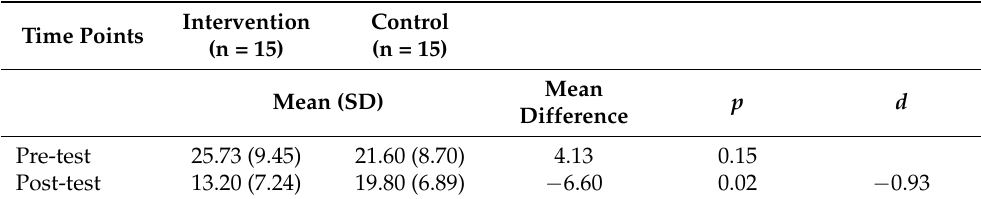
Table 2. Effects of the TPS intervention on the depression symptom score (primary outcome) between pre-and post- test (n =